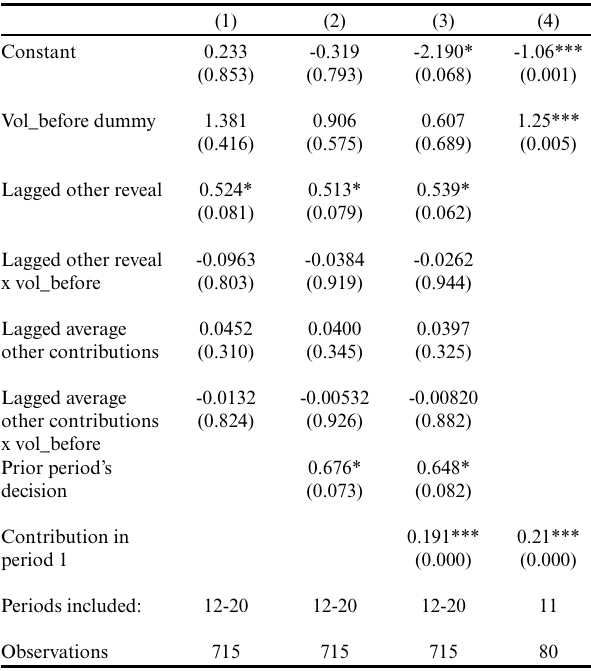
Table 4 . Regression analyses of individual level contributions given public and private